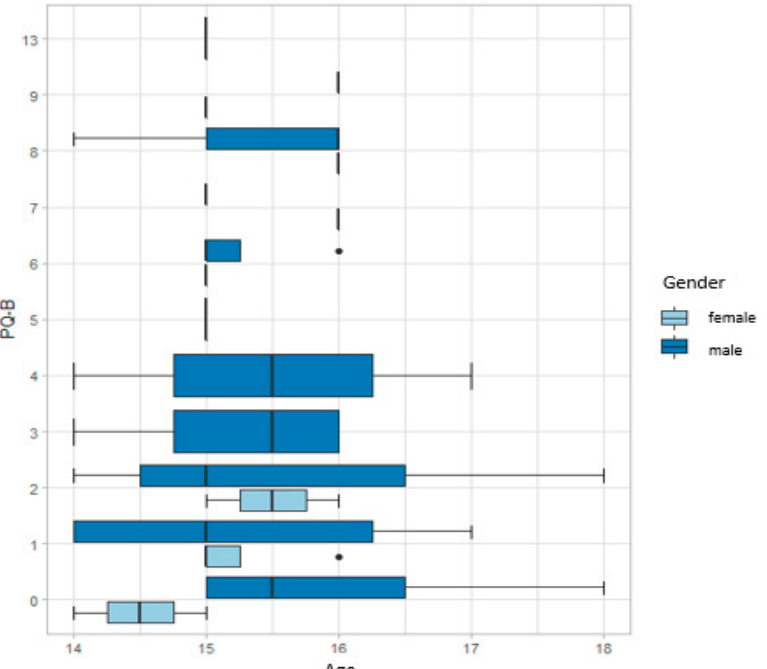
Figure 1. Results of the Prodromal Questionnaire Brief Version (PQ-B) test scores according to the age of the participants.